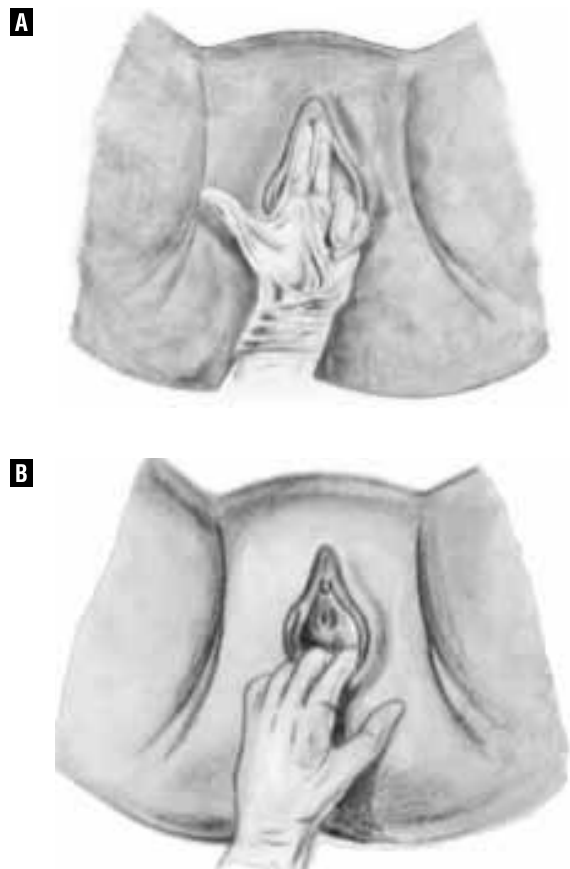
Figure 1 - Bidigital vaginal palpation regarding the vaginal introitus. (A) anterior and (B) posterior